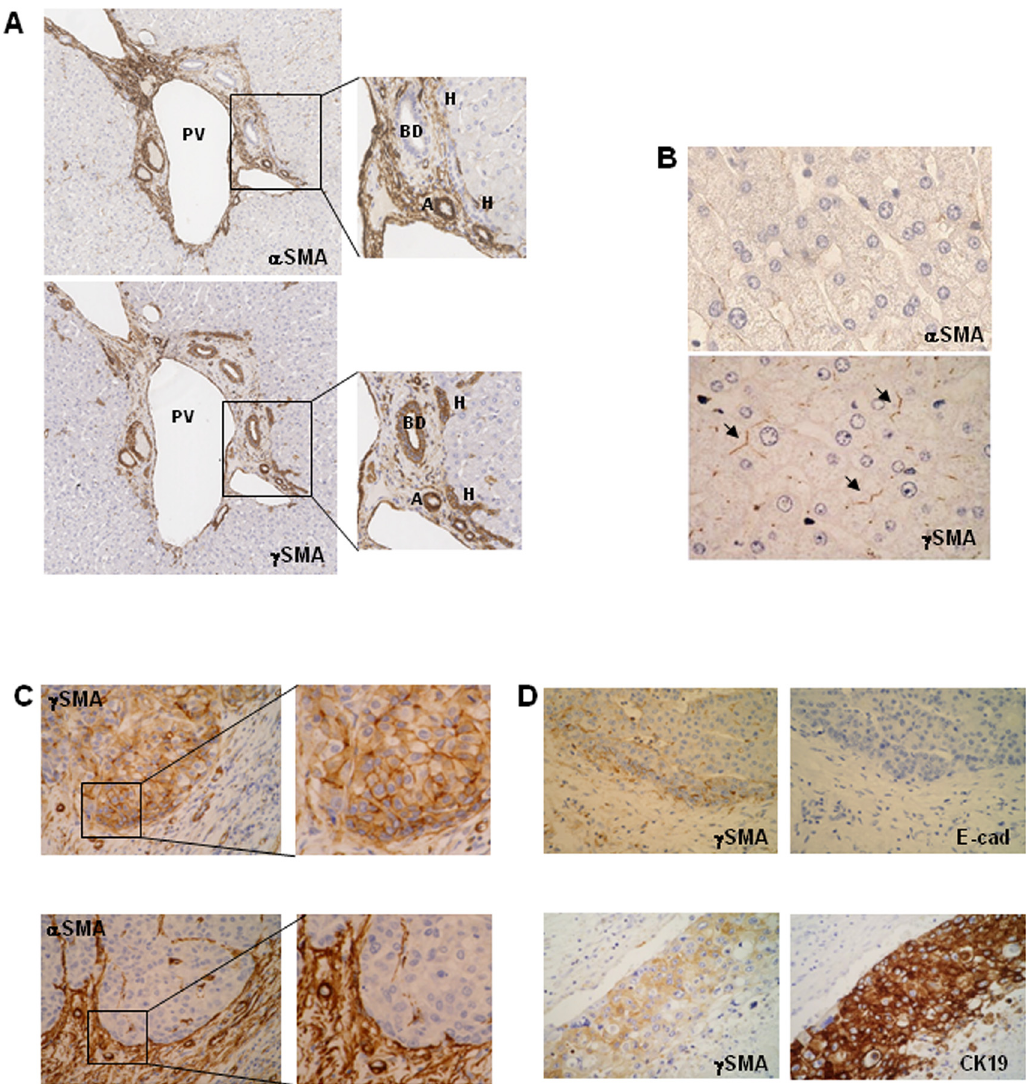
Fig 3. Immunochemical analyses of α SMA and γ SMA expression in normal and HCC livers. (A) Serial sections of normal livers were immunochemically stained with anti- α SMA or anti- γ SMA antibodies. BD: bile duct, A: artery, H: canal of Hering, PV: Portal Vein. x50. (B) Sections of normal livers were immunochemically stained with anti- α SMA or anti- γ SMA antibodies. ( ! : canaliculi) x400. (C) (D) HCC nodules were immunochemically stained with different antibodies. Serial sections stained with γ SMAand α SMA; x160 and x400 (C). γ SMA and E-Cadherin (E-cad); γ SMA and CK19 (D).